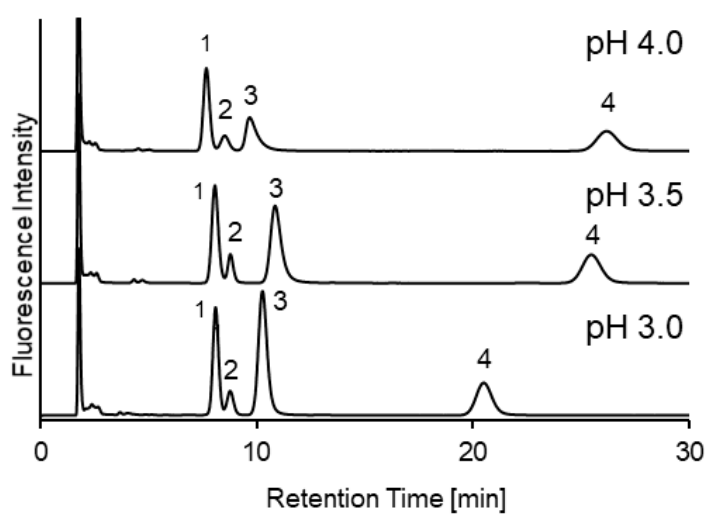
Figure 2. Chromatograms of ammonium 7-fluoro-2,1,3-benzoxadiazole-4-sulfonate (SBD)-thiol